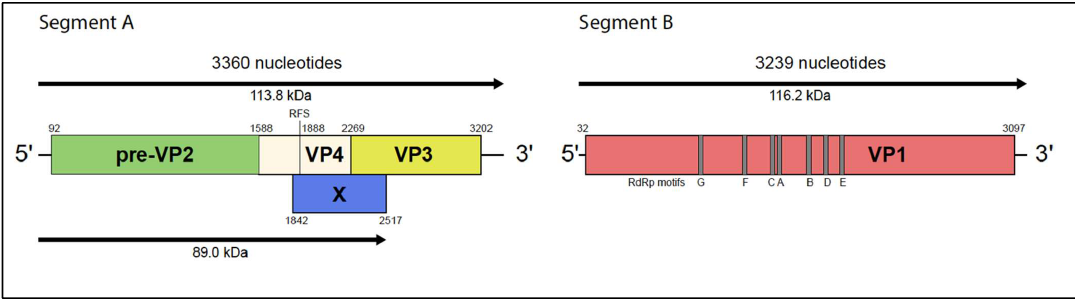
Figure 3. Genome organization of Port Bolivar virus .